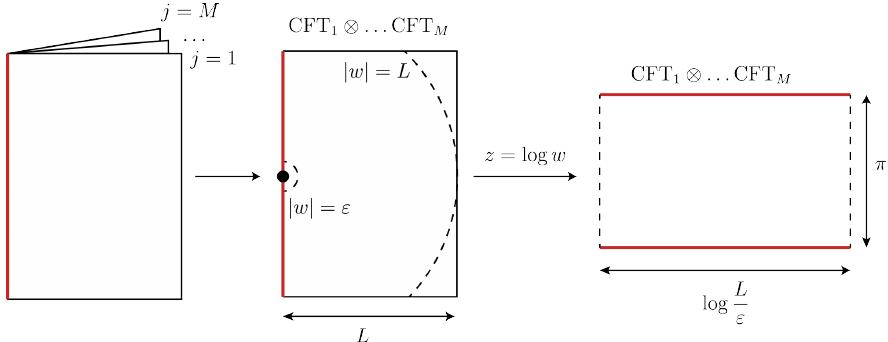
Figure 2 . The folding procedure. The junction in Euclidean spacetime is the booklet with the CFTs bound in x = 0 (left panel). The folding consists in merging together the M CFTs in a worldsheet being a single infinite strip with an appropriate boundary state | S i at x = 0 (middle panel). To compute the entanglement, we cut the system for | w | < ε and w > | L | (dashed lines) and map the M-CFT onto a rectangle of size log L × π (right) with Re( z ) ∈ [log ε, log L ] and ε Im( z ) ∈ [ − π/ 2 , π/ 2]